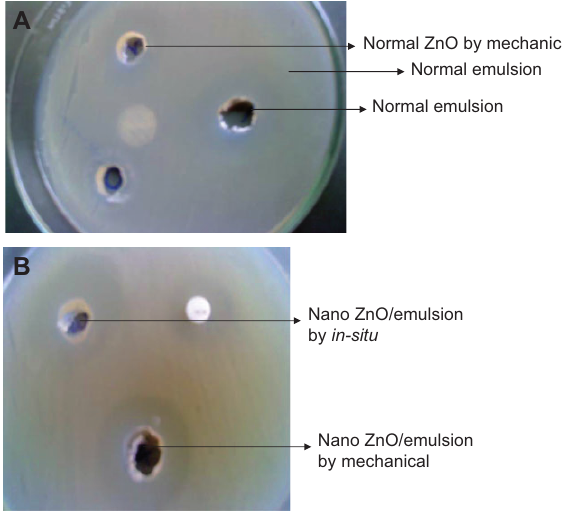
Figure 3 Images of Staphylococcus aureus incubated (A) with normal ZnO by mechanical method and normal emulsion (B) with nano ZnO/emulsion by mechanical and in situ method.